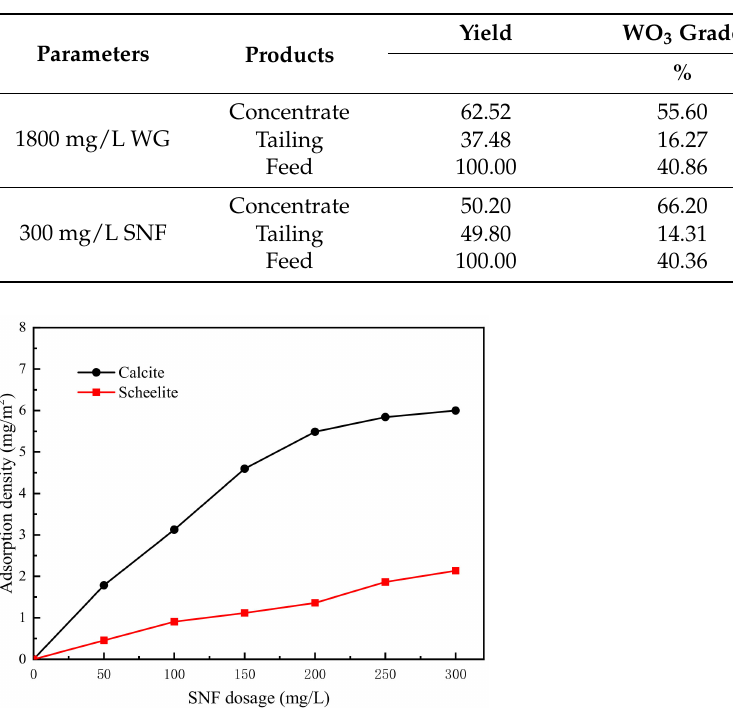
Table 3. Results of the mixed minerals flotation (C NaOL = 50 mg/L, pH ≈ 9).